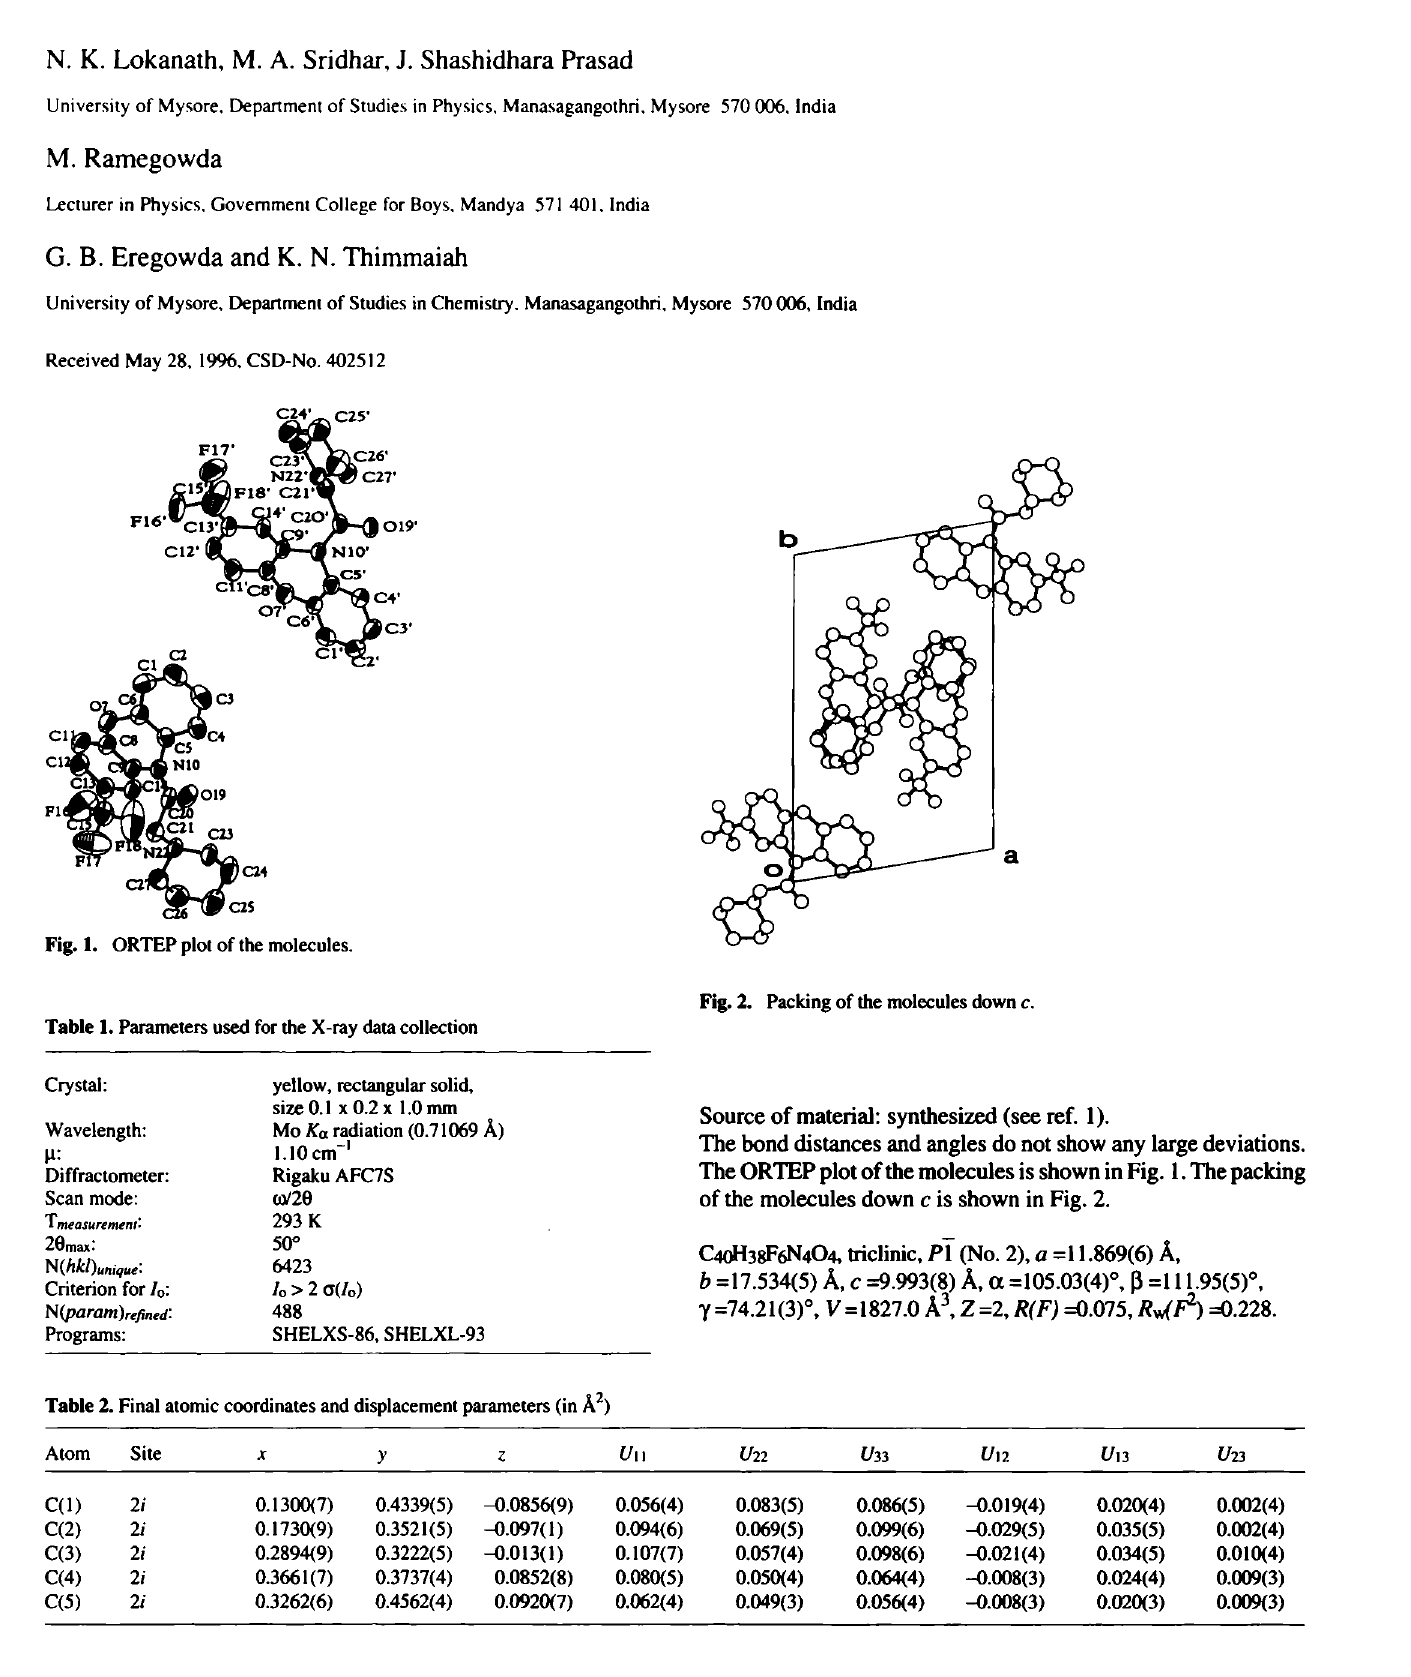
Table 2. Final atomic coordinates and displacement parameters (in Â 2